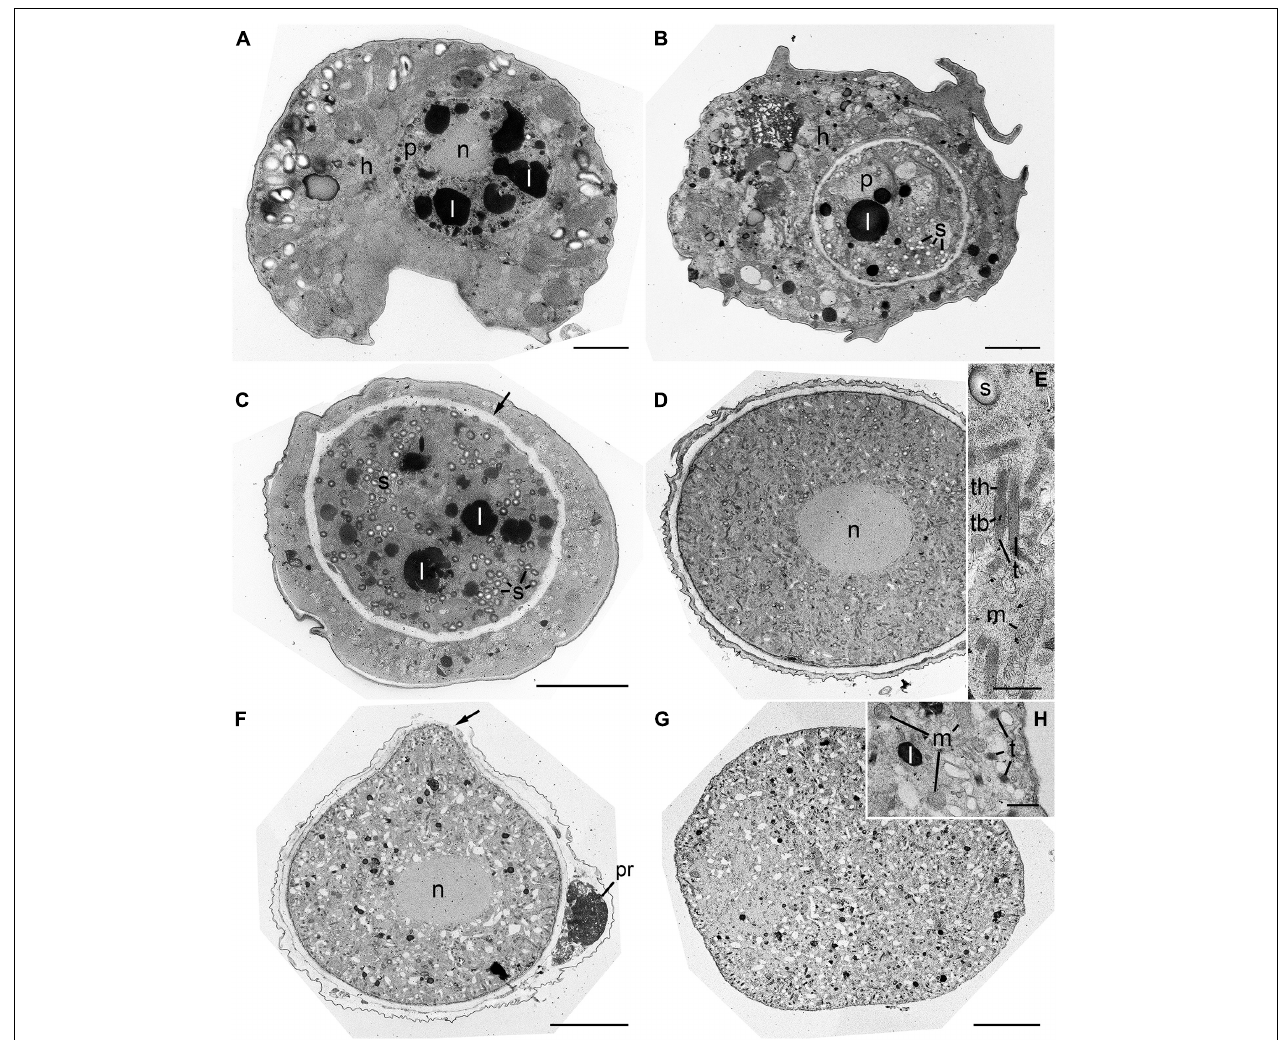
FIGURE 6 | Transmission electron microscope (TEM) images during development stages of Pararosarium dinoexitiosum . (A) The initial stage of the infection showing the trophocyte of parasitoid (p) containing a nucleus (n) and lipid globules (l) within the host cytoplasm (h). (B) Early trophocyte (p) containing starch granules (s) and lipid globule (l) within host cytoplasm (h). (C) Middle to late trophocyte showing the distinct trophocyte wall (arrow), lipid globules (l), and starch granules (s). (D) Late trophocyte showing a large non-condensed nucleus (n) and densely packed structure. (E) Enlargement of the late trophocyte showing the bipartite trichocyst (t) consisting of a head (th) and body (tb), mitochondrion (m), and starch granule (s). (F) Late trophocyte showing a nucleus (n) and the bulge of a trophocyte wall (arrow) with plastid remnants (pr) of host. (G) Sporocyte showing compact structure. (H) Enlargement of the sporocyte showing the mitochondria (m), lipid globule (l), and bipartite trichocysts (t). Scale bars: (A–D,F,G) = 5 µ m, (E,H) = 0.5 µ